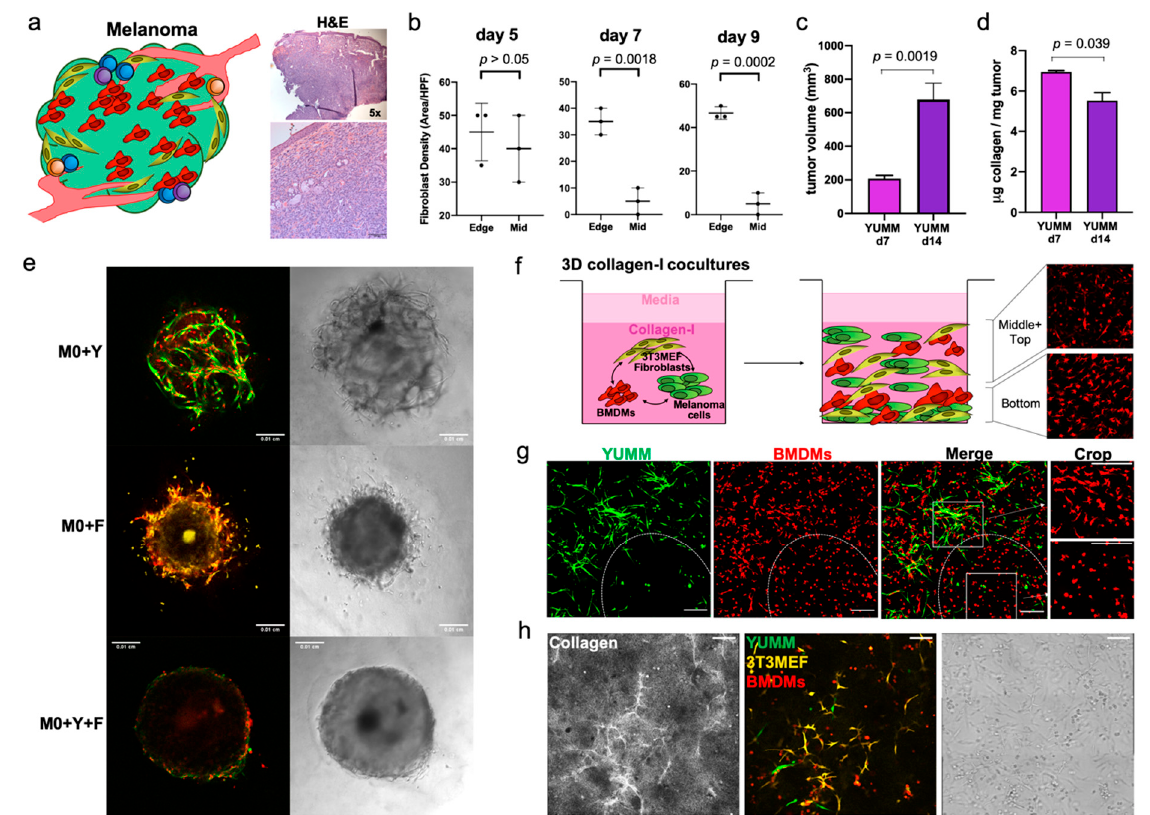
Figure 2. Mimicking the early melanoma TME with a 3D co-culture system. ( a ) Characterization of YUMM tumors. Schematic representation of the melanoma microenvironment (left) and H&E staining of tumors showing the intradermal tumor structure, infiltrating the whole dermal compartment and the subcutaneous space (right). ( b ) Quantification of EGFR + fibroblast density in two regions of the tumor, the middle (Mid) and the Edge. In this melanoma model, fibroblasts are evenly distributed across regions of early tumors but, after day 7, they are rapidly segregated to the edge. ( c ) Change in tumor volume between d7 and d14 in YUMM ( n = 6). ( d ) Quantification of soluble collagen in YUMM tumors (d7 n = 2, d14 n = 4). ( e ) Representative images of the morphology of spheroids of different compositions, embedded in collagen matrix. Y = green, M0 = red, F = yellow. ( f ) Schematic of the proposed translation of the melanoma TME into a 3D collagen cultures for in vitro analysis, combining BMDMs with YUMM cells and fibroblasts. After a few days in these cultures, BMDMs show different activation states, depending on their and the presence of other cells. ( g ) Representative image of a YUMM+BMDM 3D culture seeded as a single cell suspension of the cells. The white ellipse delineates an area where macrophages are located further away from YUMM cells. Inserts on the right are cropped areas delineated by the dotted squares. Zoomed-in images of how macrophages differ in morphology as soon as 24 h after starting the co-culture, Scale bar in 200 µm. ( h ) Representative images of collagen remodeling at 48 h post gel embedding, containing unstimulated BMDMs (M0), 3T3MEF fibroblasts and YUMM cells. Initial cell seeding number M0: 24 × 10 3 /well, YUMM: 2 × 10 3 /well. Fibroblast: 6 × 10 3 /well, in 10 µL gel. Scale bars are 100 µm.